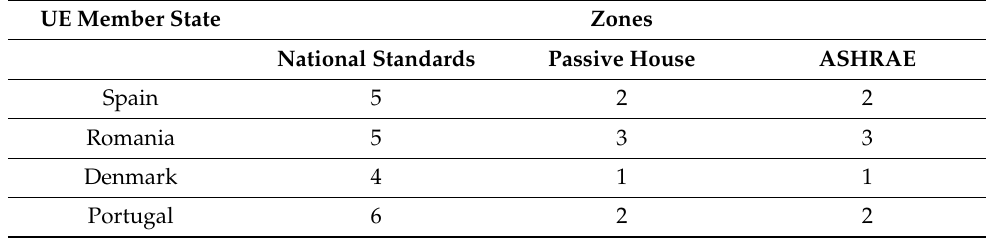
Table 10. Number of comparative